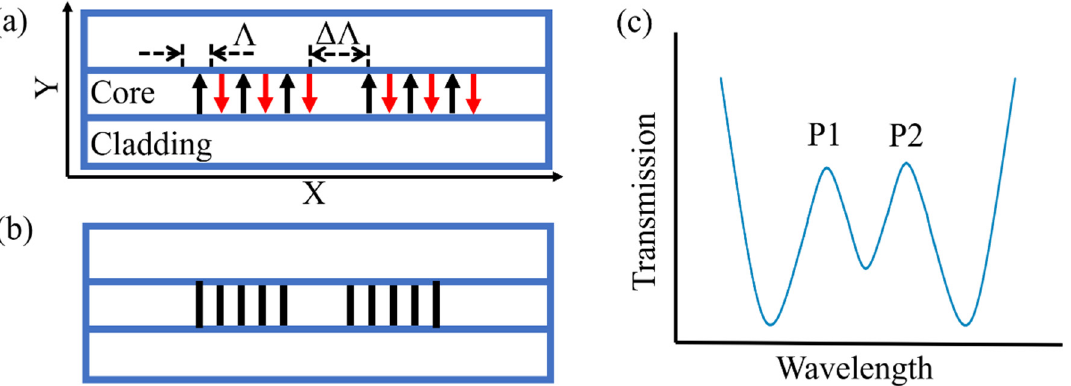
Figure 12. ( a ) The processing path of PS-FBG processed by line-by-line technology. ( b ) Schematic diagram of the designed PS-FBG. ( c ) The spectrum diagram when the original polarization state of input light is ~45°.